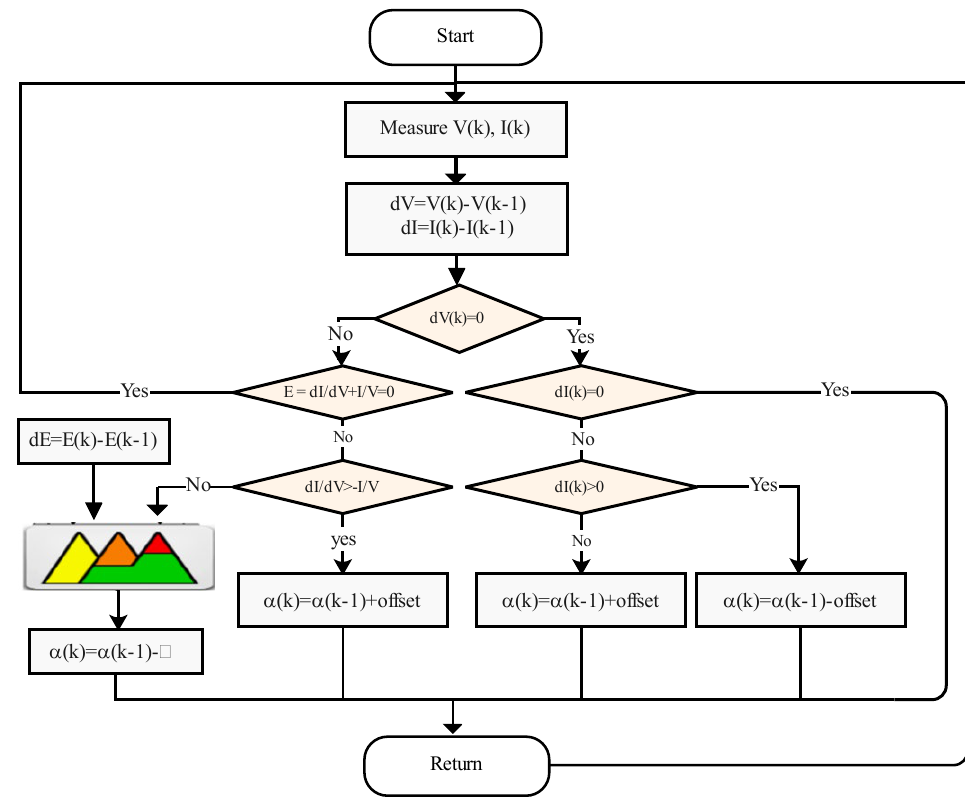
Figure 8. Fuzzy logic controller structure.